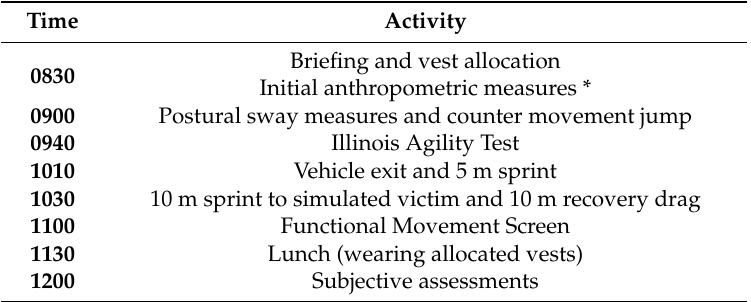
Table 2. Schedule for each day of